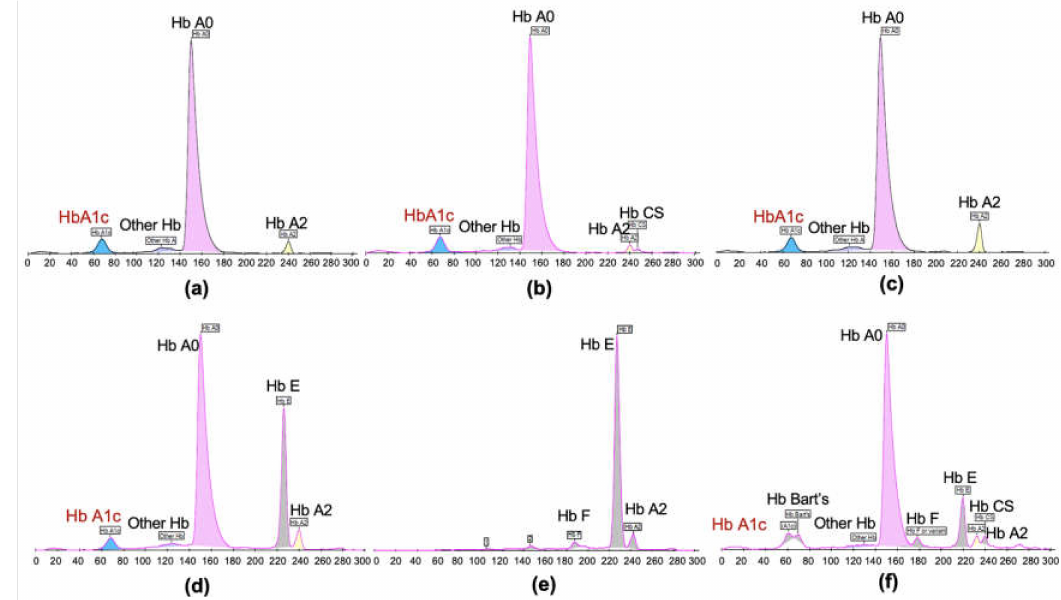
Figure 1. Chromatogram of HbA1c determination on CE of Hb variants’ samples. ( a ) A2A: Normal; ( b ) Hb CS trait; ( c ) β -thalassemia trait; ( d ) Heterozygous HbE; ( e ) Homozygous HbE; ( f ) CSEA